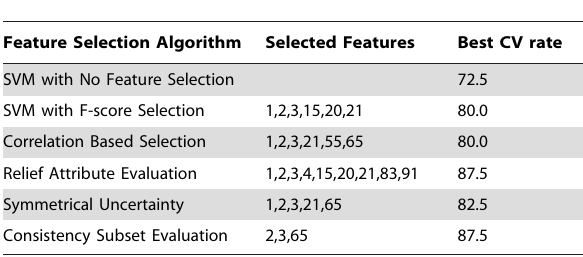
Table 8. Control vs ROCK-inhibitor-treated comparison of mesenchymal